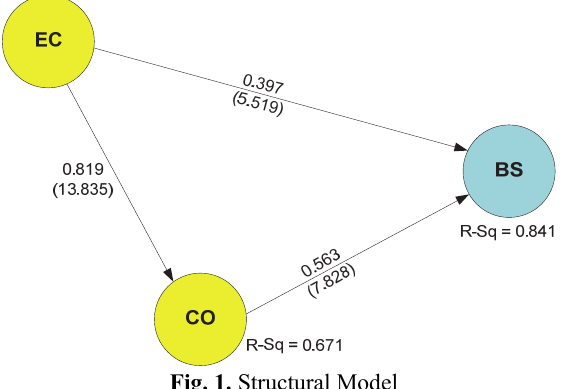
Cronbach’s Alpha Goodness of Extracted